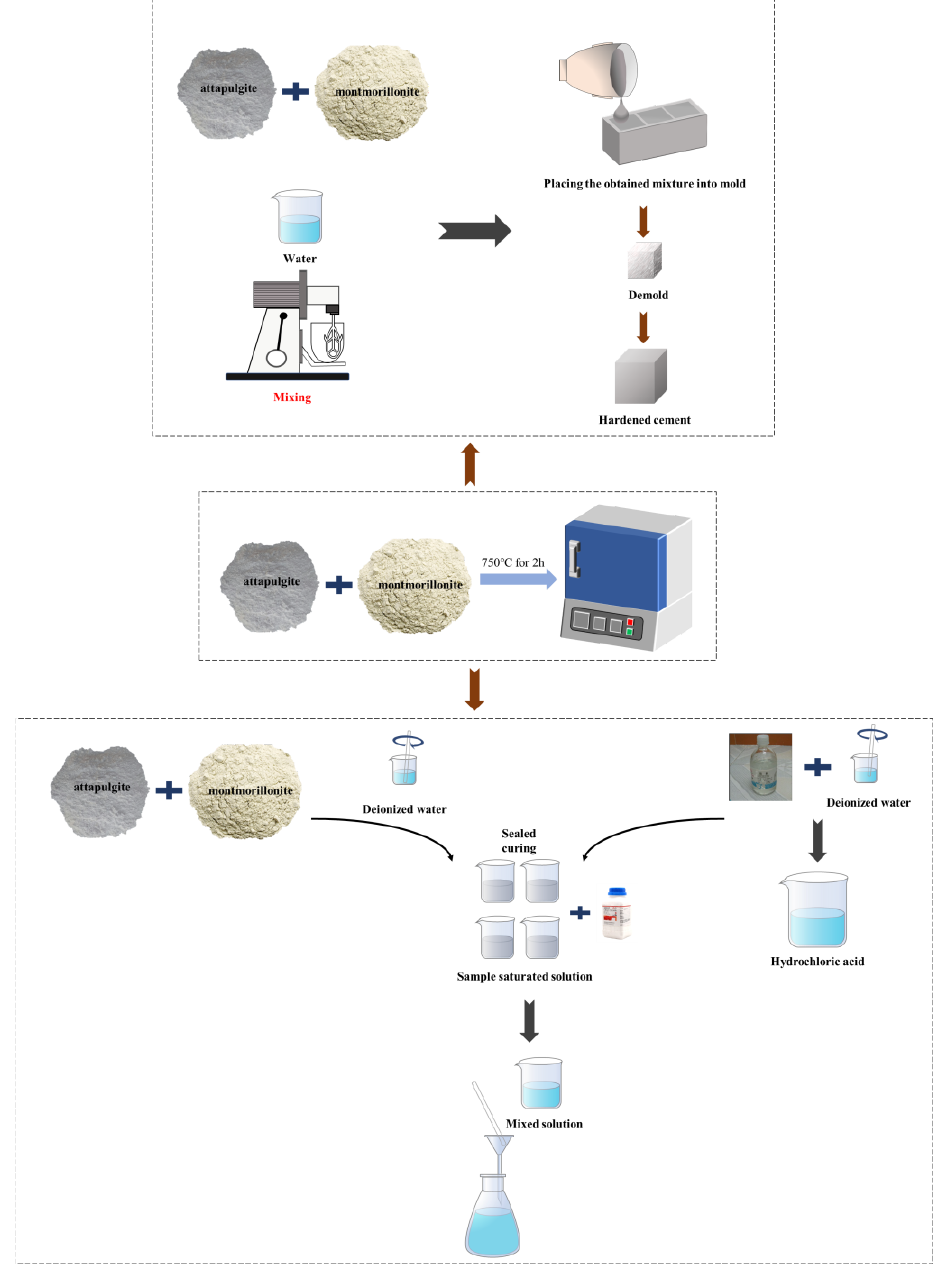
Figure 1. The flow chart. Figure 1. The flow Table 3. Proportion of cement slurry sample preparation.